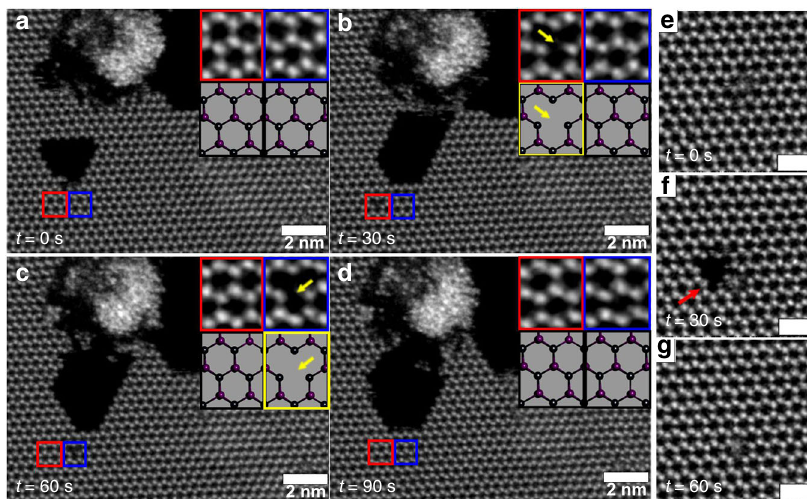
Fig. 7 Point defect formation, migration, and then reconstruction. a – d Time series of ADF-STEM images recorded after every 30 s, of point defect formation, migration, and then reconstruction. The inset under red and blue boxes in the images are high-magni fi cation images of the defects that have been marked with smaller red and blue boxes, respectively, in the same image. The inset fi gures in black and yellow boxes below the high-magni fi cation insets are the corresponding atomic models. The yellow boxes and arrows in b and c highlights the formation of a point vacancy and its migration in the inset above, before fi nally reconstructing in d . e – g Time series of ADF-STEM images recorded at an accelerating voltage of 80 kV after every 30 s of electron beam exposure. The red arrow in f shows the formation of seven vacancy defect, but it gets quickly reconstructed in image g after another 30 s of exposure. The scale bars in e – g correspond to 1